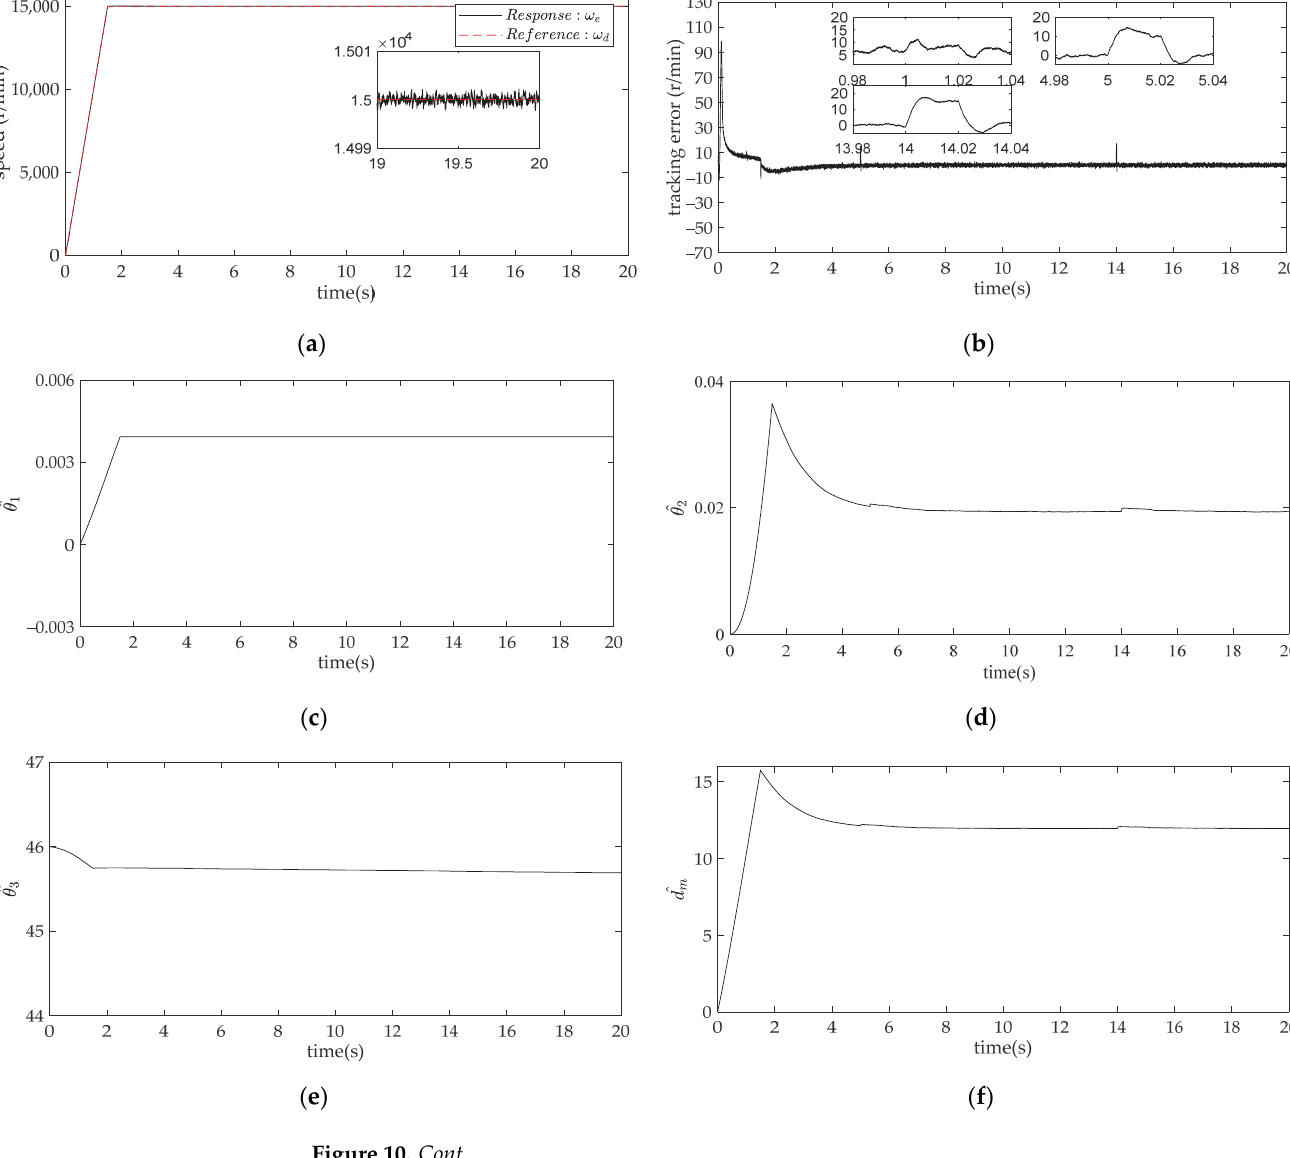
( g ) Figure 10. ( a ) Speed response of adaptive robust control in the presence of external disturbances; ( b ) Tracking error of adaptive robust control in the presence of external disturbances; ( c – g ) Param ‐ eter adaptation of adaptive robust control in the presence of external disturbances. 5. Conclusions In this paper, a sensorless control method has been designed. The estimation of core loss resistance and stator inductance has been used in the design of a sliding mode ob ‐ server to reduce the estimation error related to parameter fluctuation. At the same time, the characteristic model has been used to design the speed controller, and the adaptive rate robust control rate has been designed to realize the accurate compensation of the sys ‐ tem model and suppress the external interference of the high ‐ speed motor system. Finally, the simulation results have been given to show that the proposed control method im ‐ proves the accuracy of the rotor position estimation and speed tracking. In future work, we will further study the sensorless control of permanent magnet synchronous motors in the full ‐ speed range and try to combine the low ‐ speed operation control algorithm with the high ‐ speed operation control algorithm.